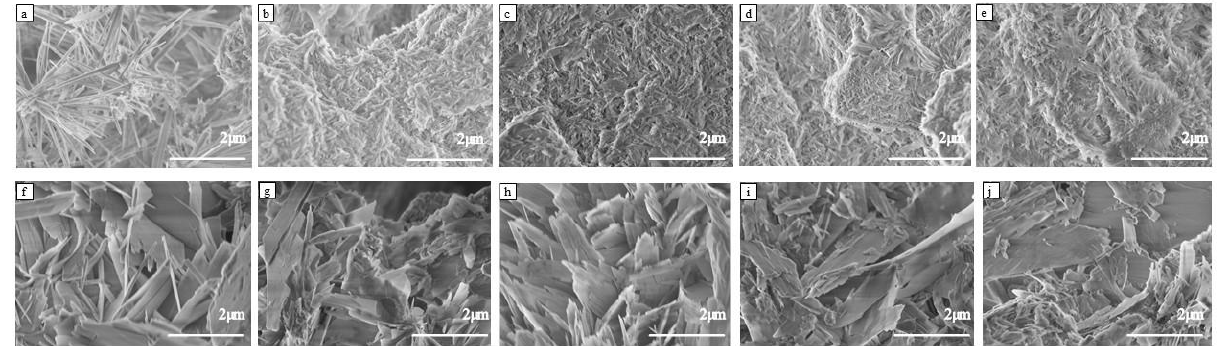
Figure 7. SEM micrographs of the samples after solvothermal treatment under ratio 40:60 of water to ethylene glycol Asp:005:EG ( a ), Asp:025:EG ( b ), Asp:05:EG ( c ), Asp:075:EG ( d ), and Asp:1:EG ( e ); and Sa:005:EG ( f ), Sa:025:EG ( g ), Sa:05:EG ( h ), Sa:075:EG ( i ), and Sa:1:EG ( j